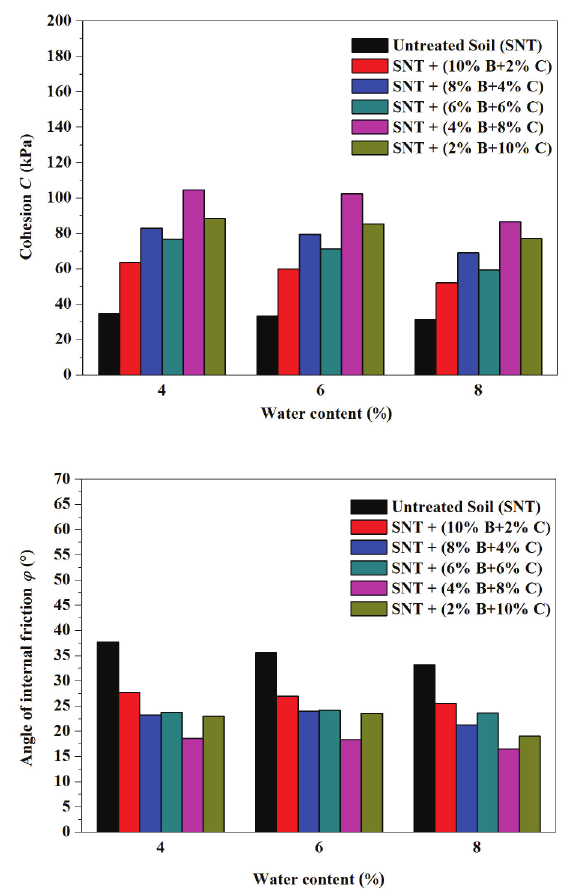
Figure 6: Evolution of the cohesion ( C ) and the internal friction angle ( φ ) in the different